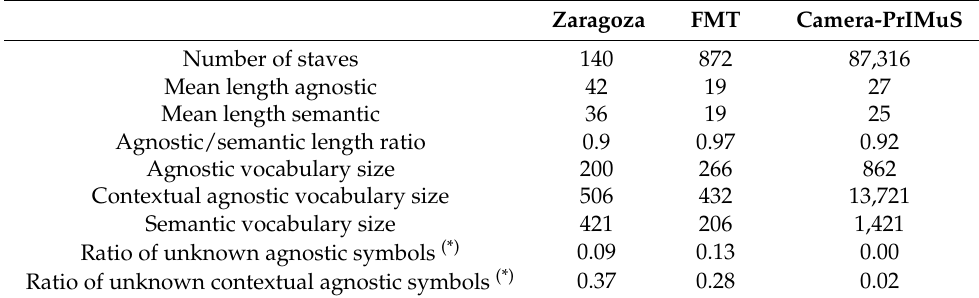
Table 1. Characterisation of